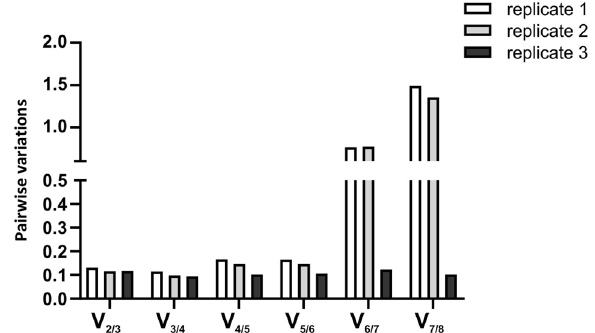
Figure 1. Pairwise variations (V n/n+1 ) for all three replicate experiments. A large variation between two sequential normalization factors means that the added gene has a significant effect and should be preferably included for calculation of the normalization factor. Addition of a 3 rd reference gene does not result in further improvement to the normalization factor in each of the three